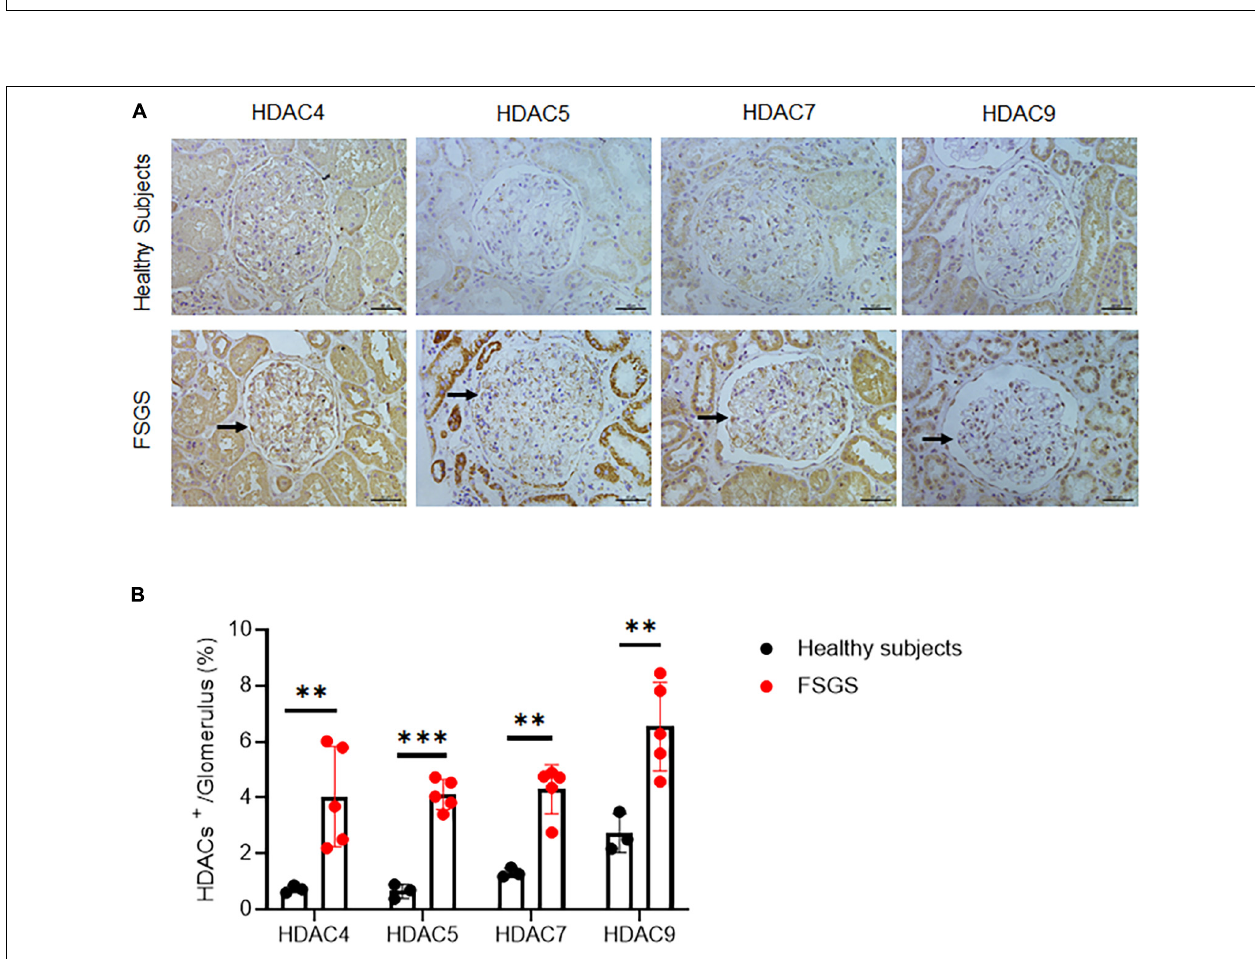
FIGURE 1 | Glomerular expression of HDAC IIa in patients with FSGS using Nephroseq database. HDAC IIa members mRNA expression (median-centered Log 2 expression value) in dissected glomeruli from healthy living donor ( n = 21) and FSGS ( n = 25). Statistical analysis was performed with two-tailed, unpaired t -test.